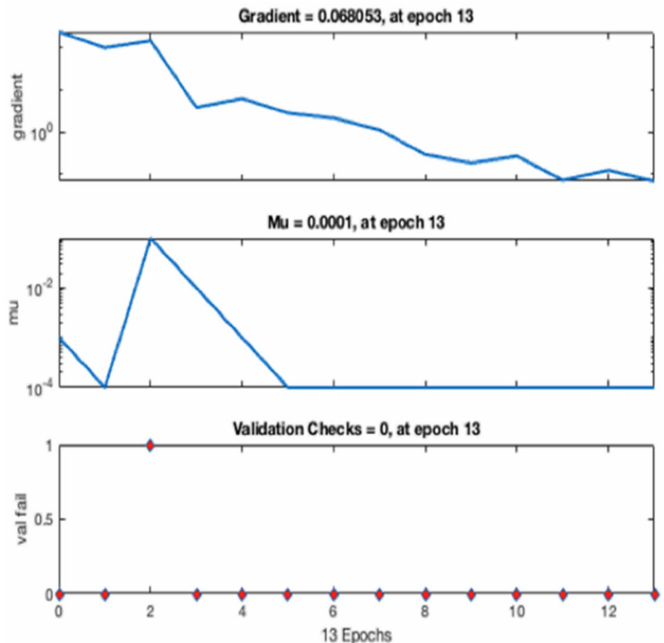
Figure 9. Validation in the training phase of model two.